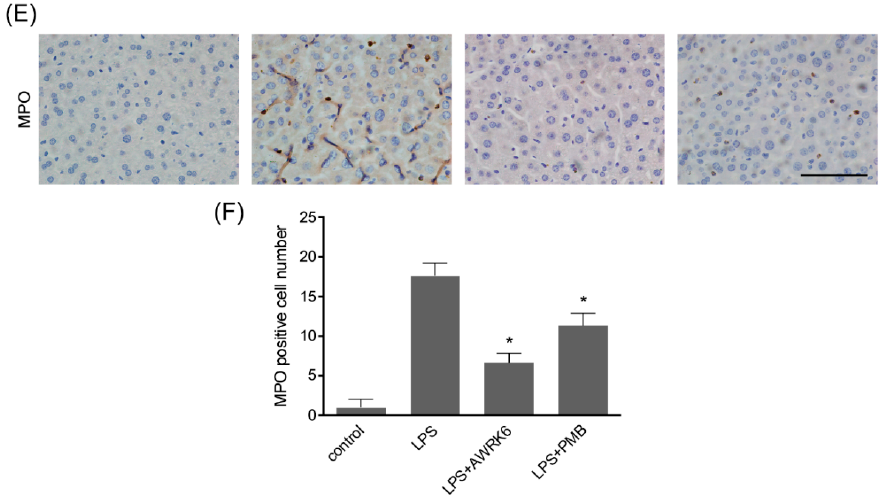
Figure 1. AWRK6 relieved lipopolysaccharide (LPS)-induced liver injury in mice. The mice were administrated with LPS (50 mg/kg) by intraperitoneal injection. AWRK6 (10 mg/kg) or PMB (10 mg/kg) was administered intraperitoneally 1 h after LPS and an equal volume of sterile saline was